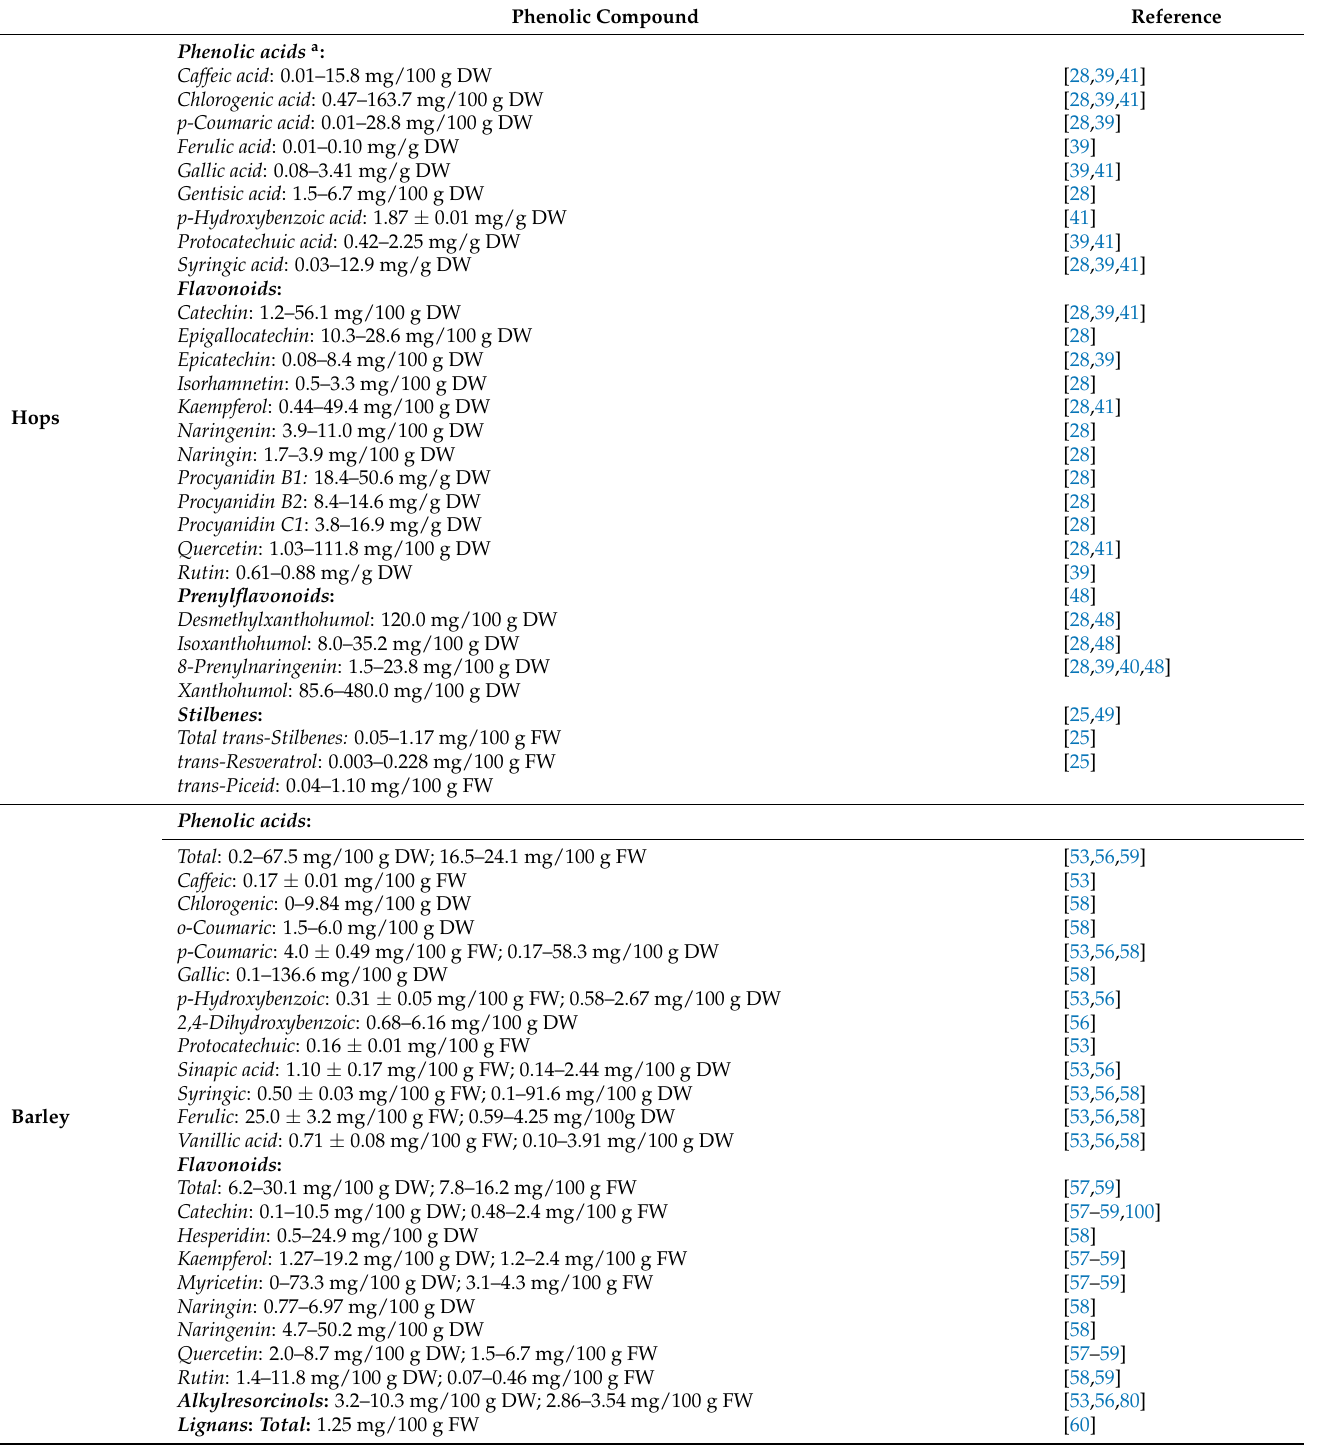
Table 1. Contents of bioactive phenolic compounds in common beer